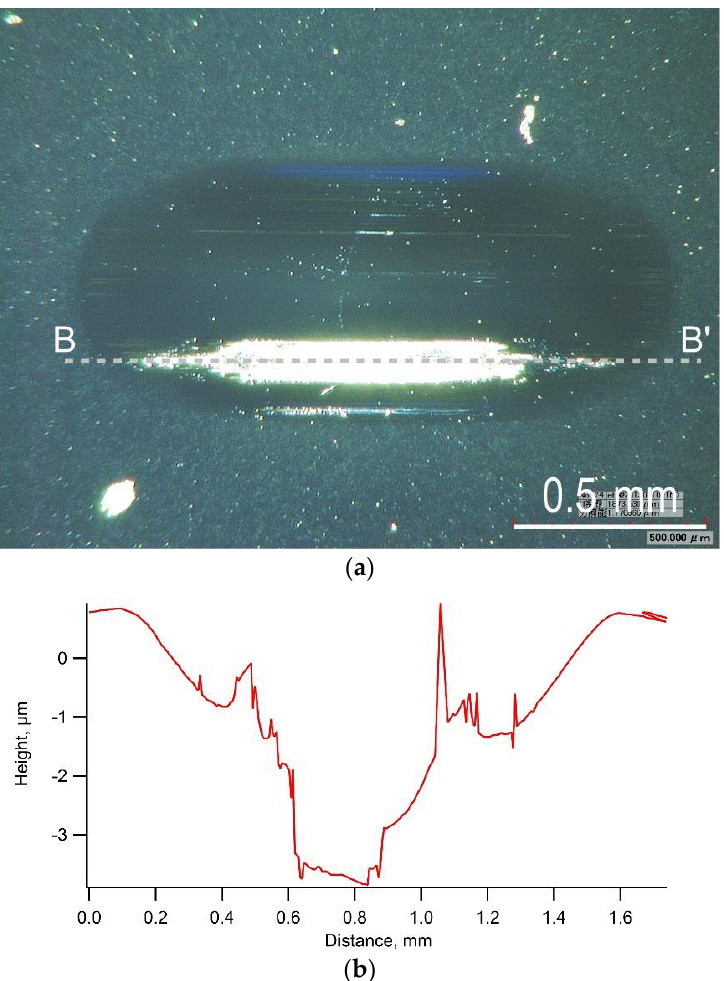
Figure 6. Typical example of the appearance of wear scar and its cross-section shape observed in the test using a-C:H film: ( a ) Appearance of wear scar on test plate, ( b ) Cross-section shape along